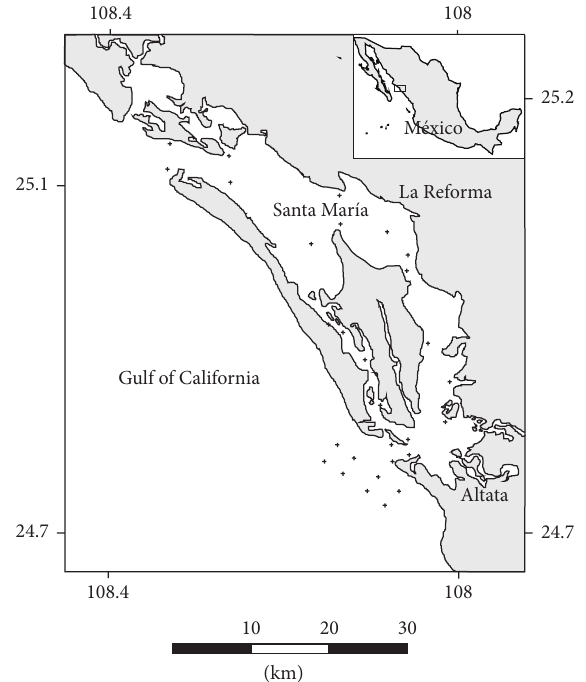
Figure 1: Studied area and sampling stations